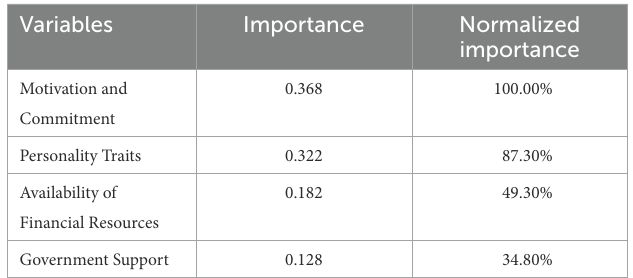
TABLE 8 Independent variable